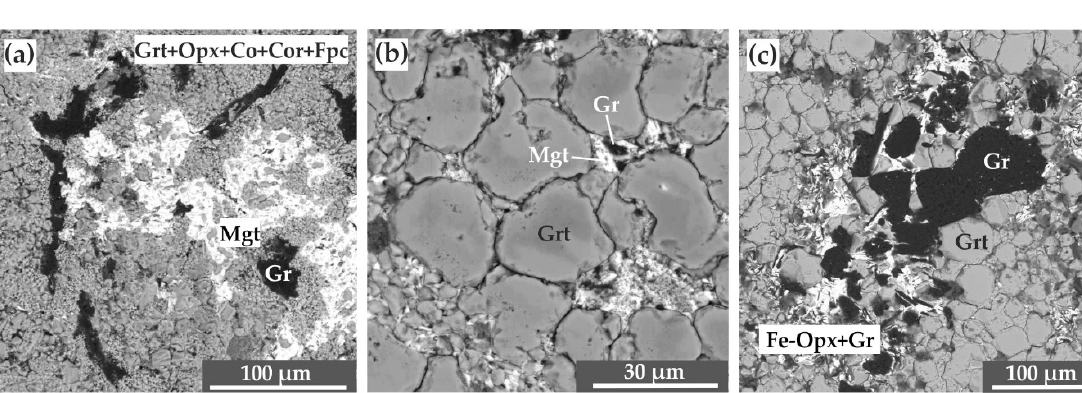
Figure 6. SEM-micrographs (BSE-regime) of polished fragments of the samples (“mixture”-type experiments, Fe 3 C–Al 2 O 3 –SiO 2 –(Mg,Ca)CO 3 system, P = 6.3 GPa): ( a ) polycrystalline aggregate of newly-formed garnet, orthopyroxene, magnetite and graphite and recrystallized cohenite and corundum (1100 °C); ( b ) zoned garnet crystals with magnetite + graphite in the interstitials (1300 °C); and ( c ) graphite + Fe-rich orthopyroxene assemblage in polycrystalline garnet aggregate (1500 °C). Grt, garnet; Opx, orthopyroxene; Cor, corundum; Co, coesite; Mgt, magnetite; Opx, orthopyroxene; Gr, graphite; Fe-Opx, Fe-rich orthopyroxene; Fpc, ferropericlase.